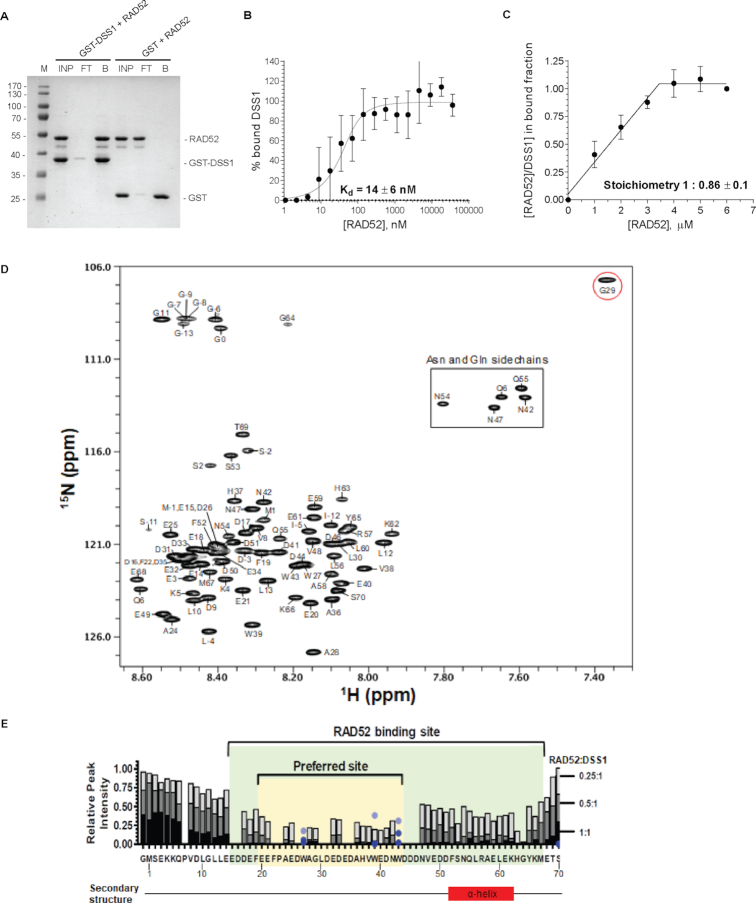
DSS1 interacts with RAD52 with high affinity and 1:1 stoichiometry. (A) GST pull-down assay with GST-DSS1 and RAD52 (5 μM each). The input (INP), the flow through (FT) and the bound (B) fractions were analysed. (B) Microscale Thermophoresis (MST) analysis of RAD52 interaction with DSS1. The data represent the average ± SD for two sets of three independent experiments. In each experiment the data were normalized to the average value of the last three data points set as 100% bound. Quadratic binding equation was used to calculate the Kd. (C) Quantification of the pull-down experiments with GST-DSS1 immobilized on the beads and increasing concentration of RAD52. The data are shown as the average and standard deviation of three independent experiments. (D) Assigned 15N/1H HSQC spectrum of DSS1 with peaks labelled using DSS1 protein sequence numbering. The extra N-terminal tag (17 residues of GSPGISGGGGGILDSMG) in the protein construct are numbered as −16 to 0. The G29 amide peak circled in red exhibits unique chemical shift. (E) NMR-based analysis of the RAD52-DSS1 interaction. Overlaid histograms of the relative peak intensity of the assigned backbone amides of DSS1 (10 μM) in the 15N/1H HSQC spectra with bars coloured in light grey, medium grey, and dark for each residue of DSS1 for the samples containing 0.25:1, 0.5:1, and 1:1 RAD52:DSS1 ratios, respectively. For each assigned residue (including the tag-derived G0), the relative peak intensity was obtained by measuring the peak intensity of 15N-labelled DSS1 in the 15N/1H HSQC spectrum in the presence of RAD52 (at indicated ratios) divided by the peak intensity in the absence of RAD52. Relative peak intensity is not shown for the two prolines and thirteen other residues whose cross-peaks were severely overlapped in the 15N/1H HSQC spectra. The light blue, medium blue, and dark blue circles indicate the relative peak intensity of the tryptophan indole NϵH cross-peaks of W27, W39, and W43 of DSS1 for the samples containing 0.25:1, 0.5:1 and 1:1 RAD52:DSS1 ratios, respectively. The region of DSS1 involved in the RAD52 interaction (E15-M67) is shaded in green, the initial/preferred binding site (E20-W43) is shaded in yellow. Existence of an α-helix (F52-K62) as predicted from the assigned backbone chemical shifts of DSS1 in the absence of RAD52 using TALOS+ program is shown below the panel.